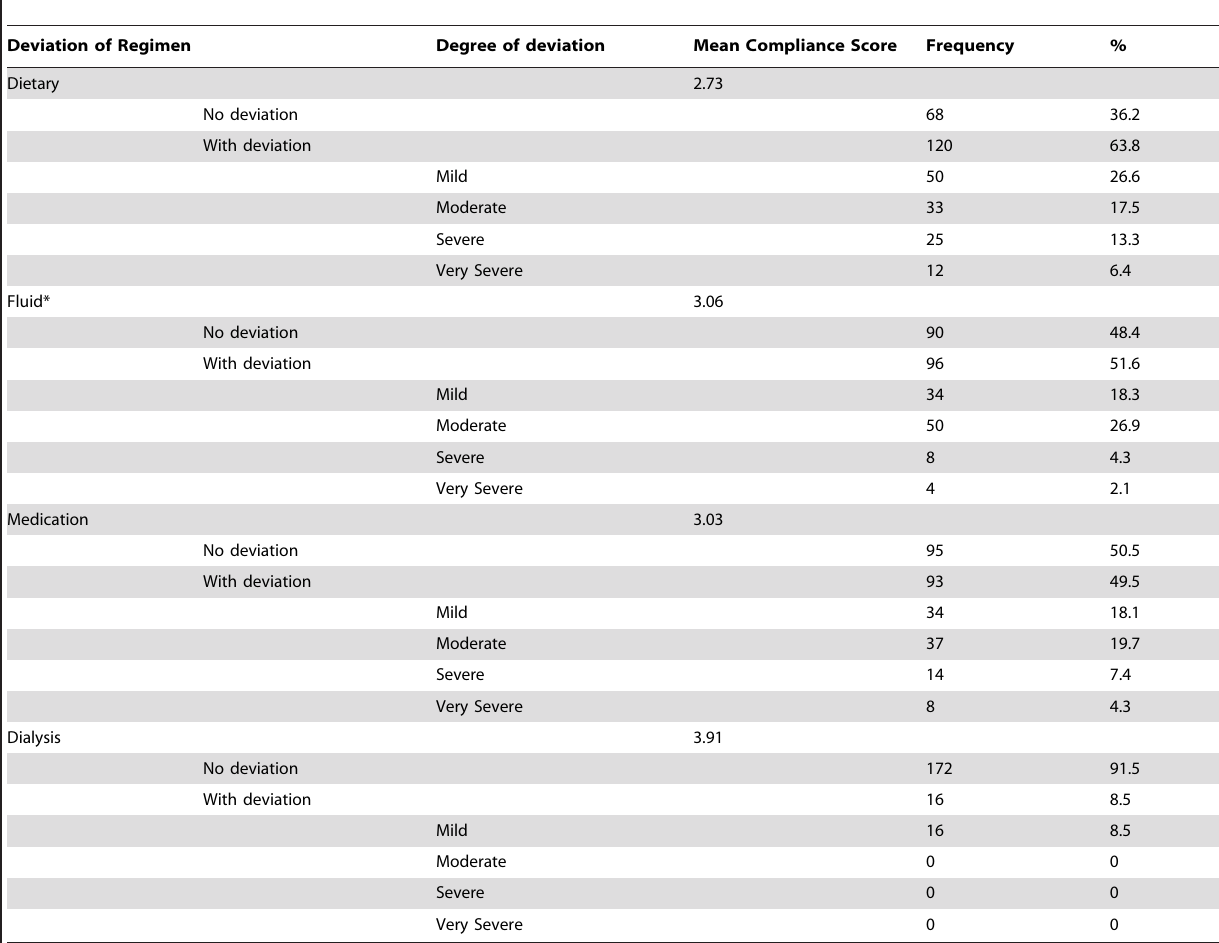
Table 3. Self-reported of intensity of treatment